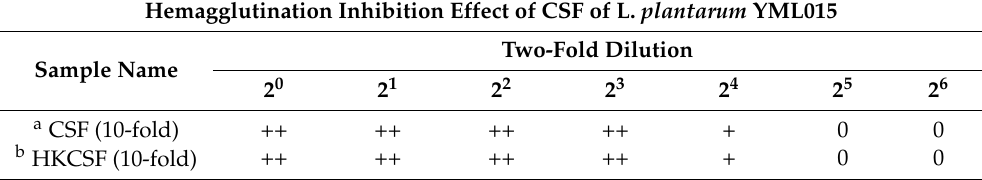
Table 5. Hemagglutination inhibition effect of CFS of L. plantarum YML015 against H1N1. Hemagglutination Inhibition Effect of CSF of L. plantarum YML015